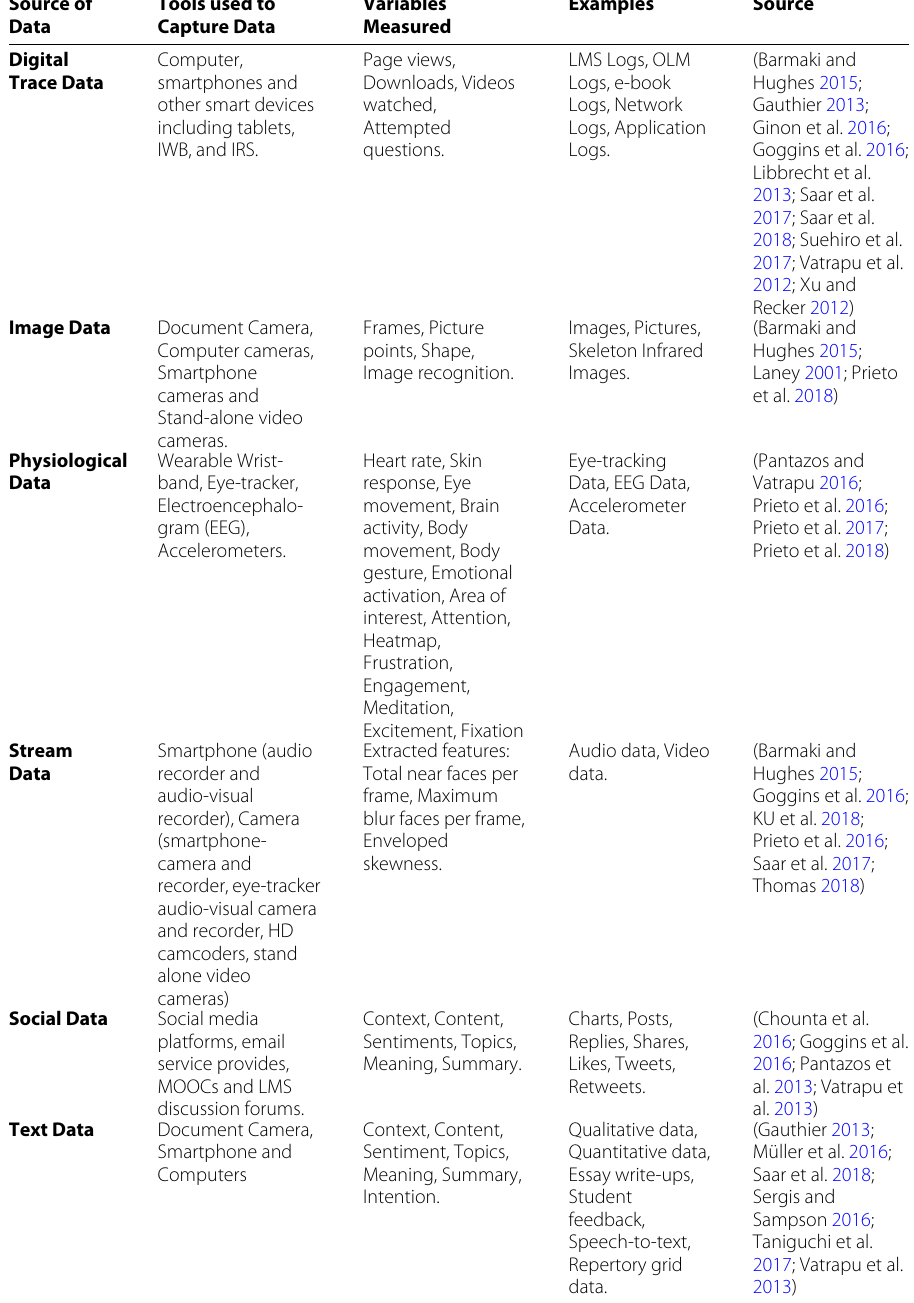
Table 2 Data Sources and Tools used for TA in